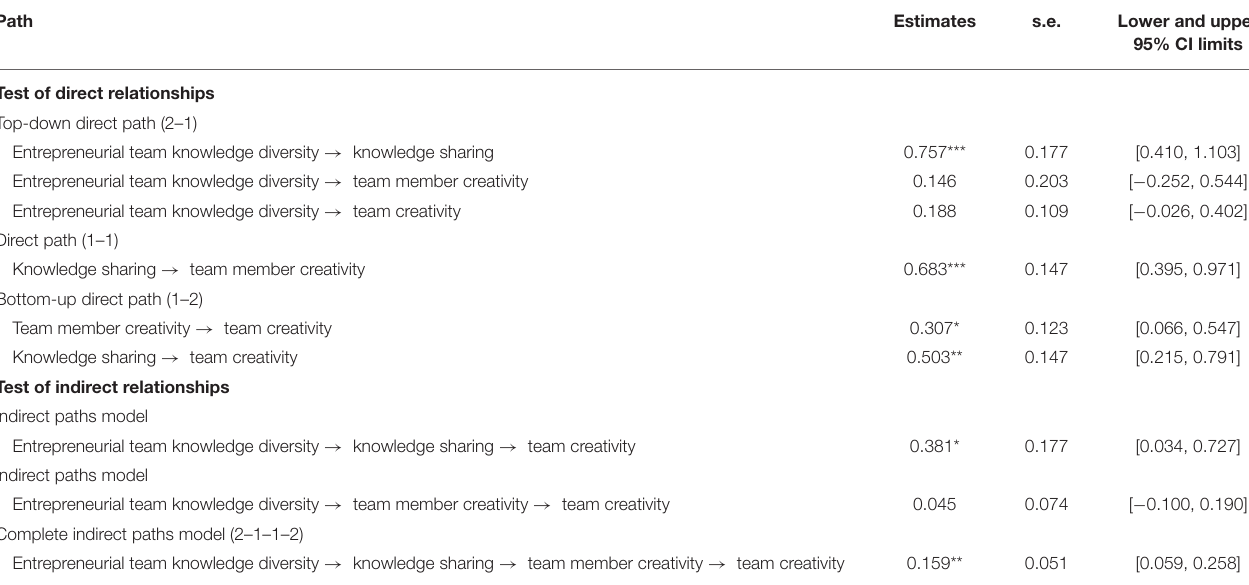
TABLE 4 | Tests of direct and indirect relationships (Hypotheses 1–4).